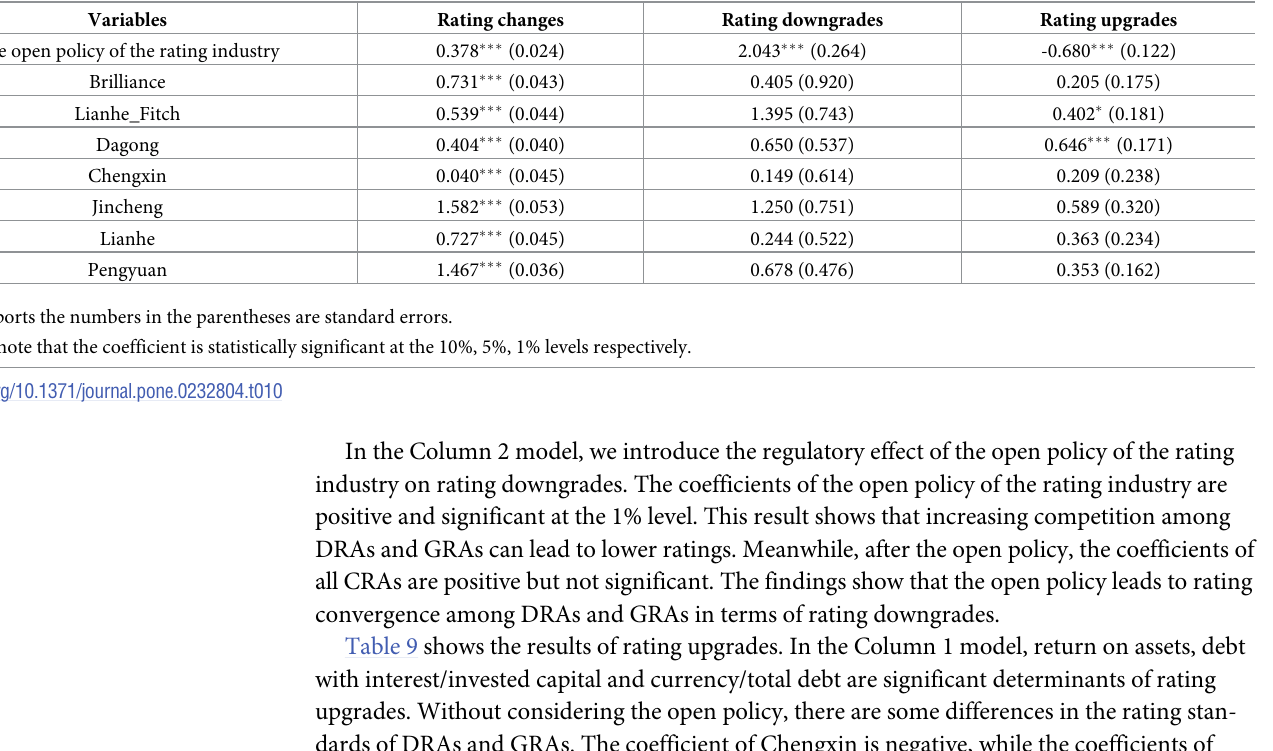
Table 10. Regression results of no control variables.